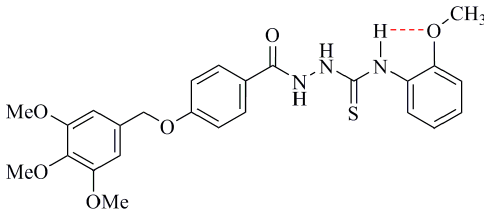
Figure 3. Formation of intramolecular hydrogen bond in compounds 3c .